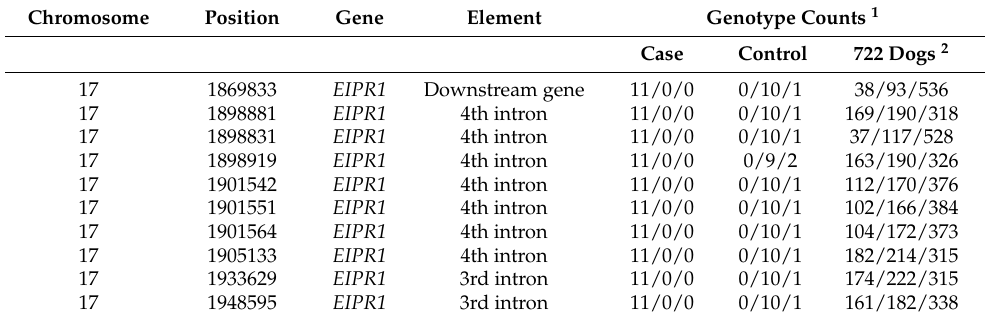
Table 4. Case-specific SNPs found in the EIPR1